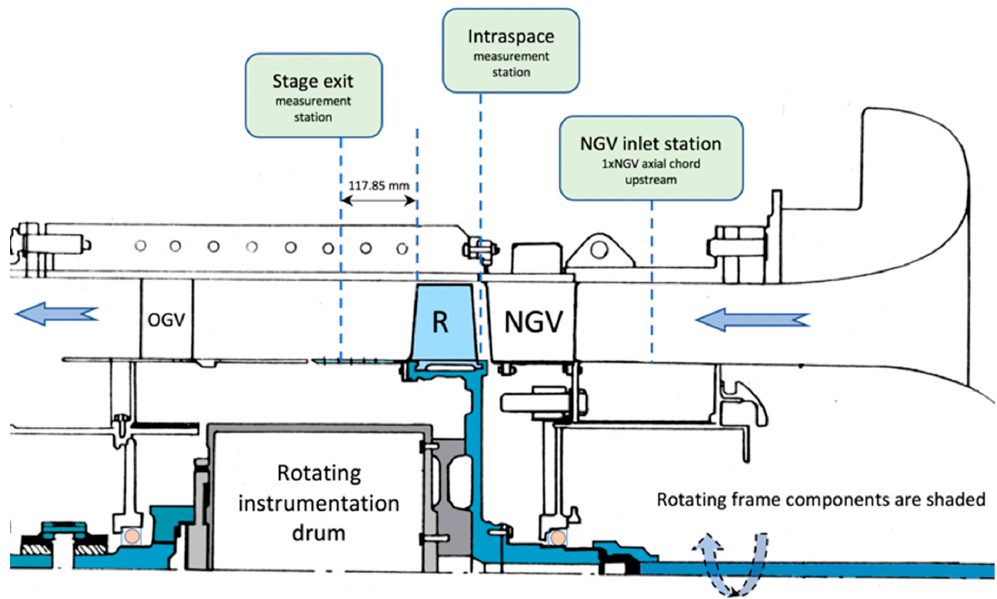
Figure 1. Cross-sectional view of the Axial Flow Turbine Research Facility (AFTRF).